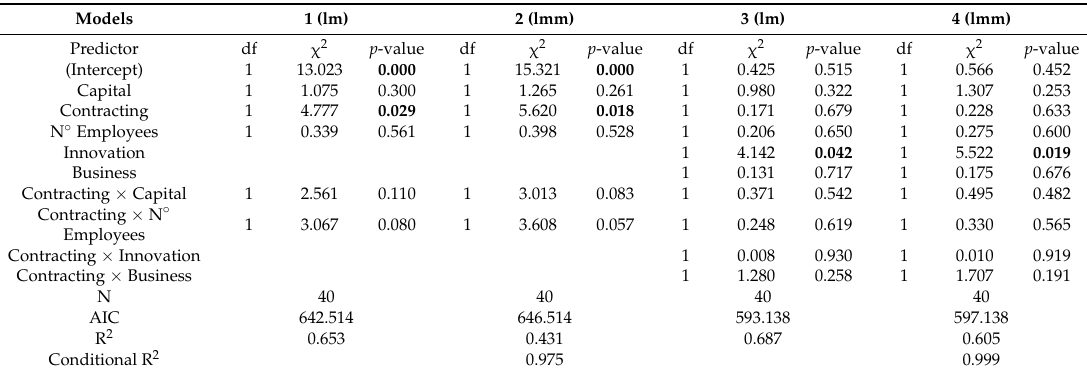
Table 5. Results of the linear and mixed linear effect models for growth in production (t/month) in the period the last ten